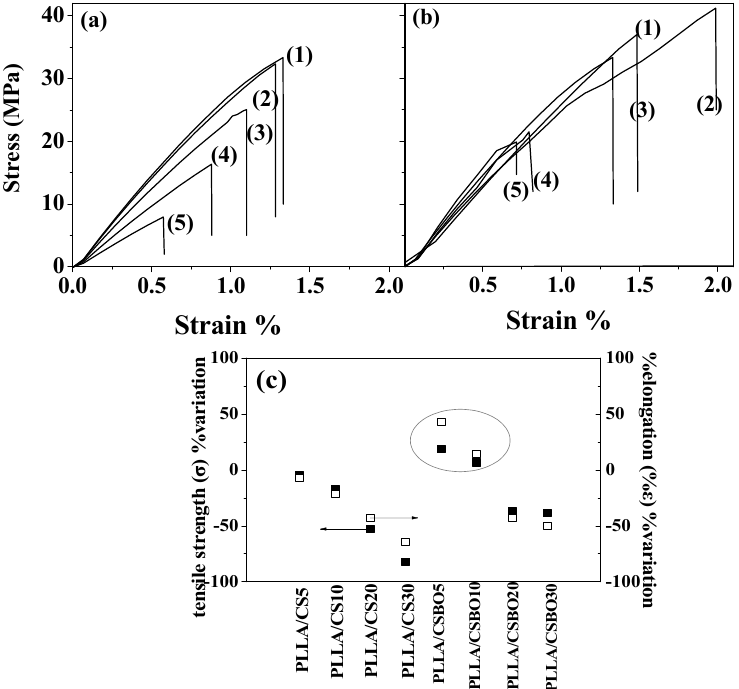
Figure 5. Strain–stress curves of ( a ) (1) PLLA, (2) PLLA/CS5, (3) PLLA/CS10, (4) PLLA/CS20, and (5) PLLA/CS30 and ( b ) (1) PLLA, (2) PLLA/CS/BO5, (3) PLLA/CS/BO10, (4) PLLA/CS/BO20, and (5) PLLA/CS/BO30, and ( c ) %variation of tensile strength ( σ ) values and %elongation at break—(% ε ) values are for all tested PLLA/CS and PLLA/CS/BO active packaging films.